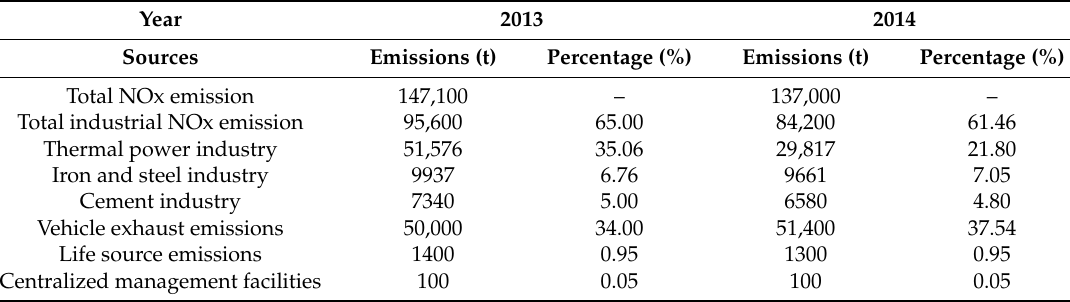
Table 2. Main pollution source of NOx in Wuhan, 2013–2014